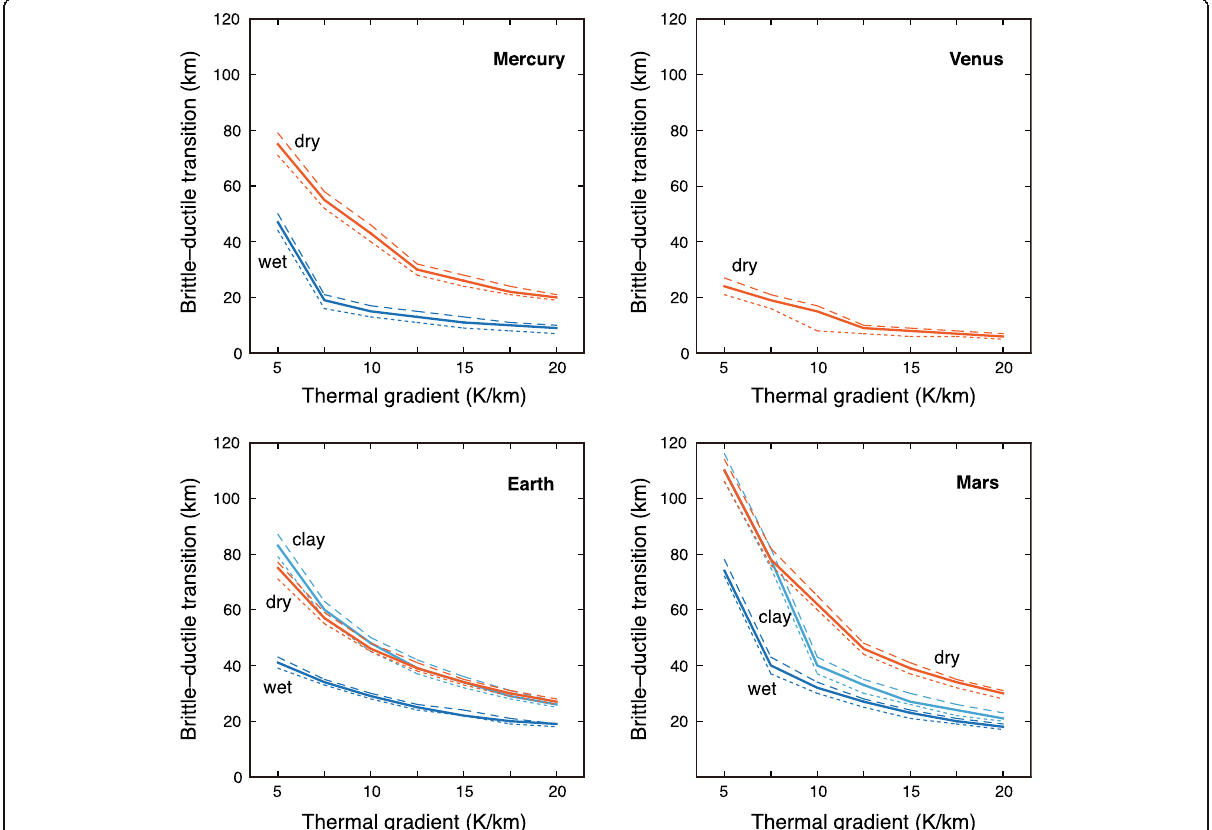
Fig. 9 Effect of thermal gradient on the depth of the brittle – ductile transition in each planet for various models. Dashed, solid, and dotted lines indicate calculation results using strain rate of 10 − 16 , 10 − 17 , and 10 − 18 s − 1 , respectively. The tensional stress field is assumed at shallow depths, and the parameters for the calculations are listed in Tables 1 and 2